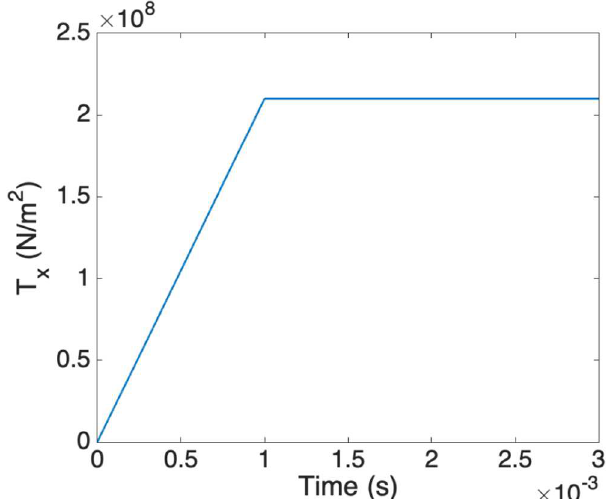
Fig. 13. Applied traction along the x -direction on the patch surface x = H ω x